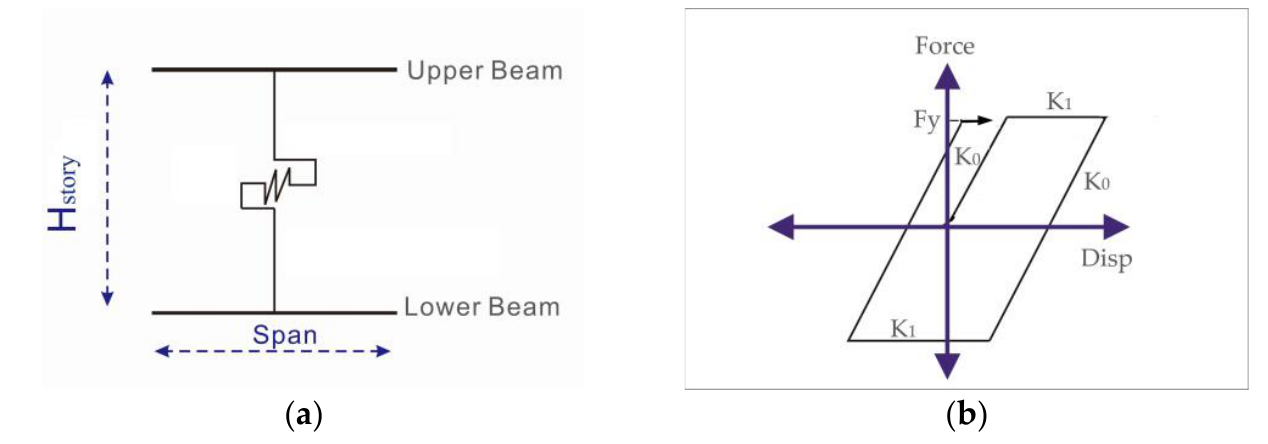
Figure 2. Hysteresis damper: ( a ) element model, ( b ) bi-linear force – displacement relationship.